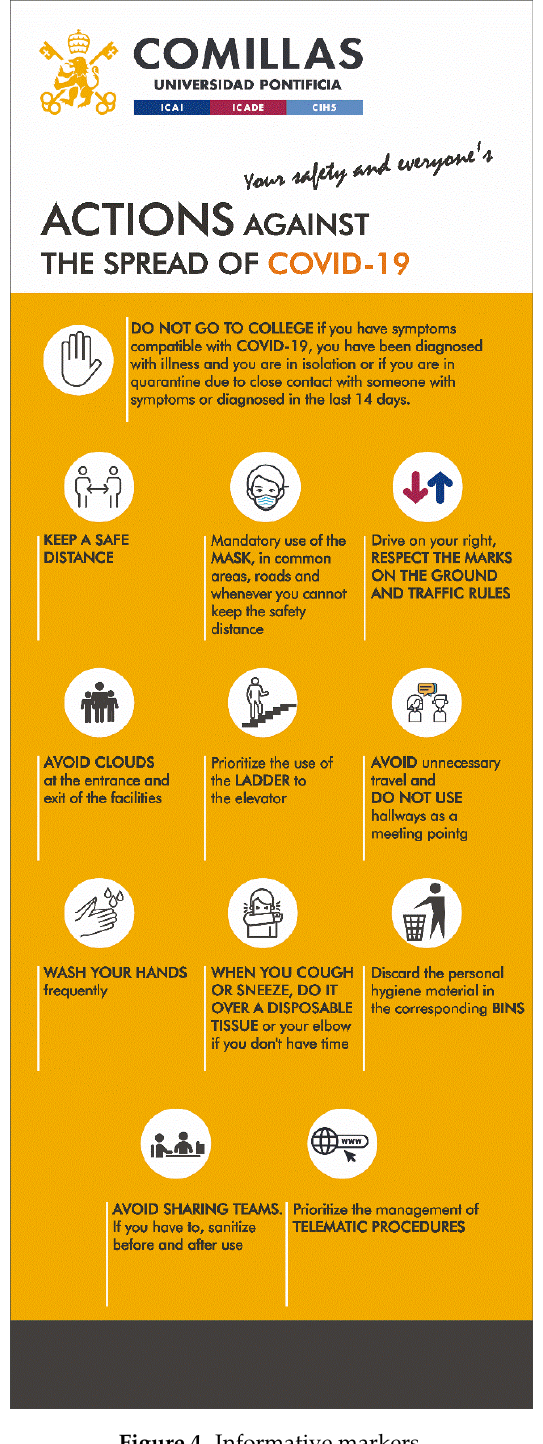
Figure 4. Informative markers.